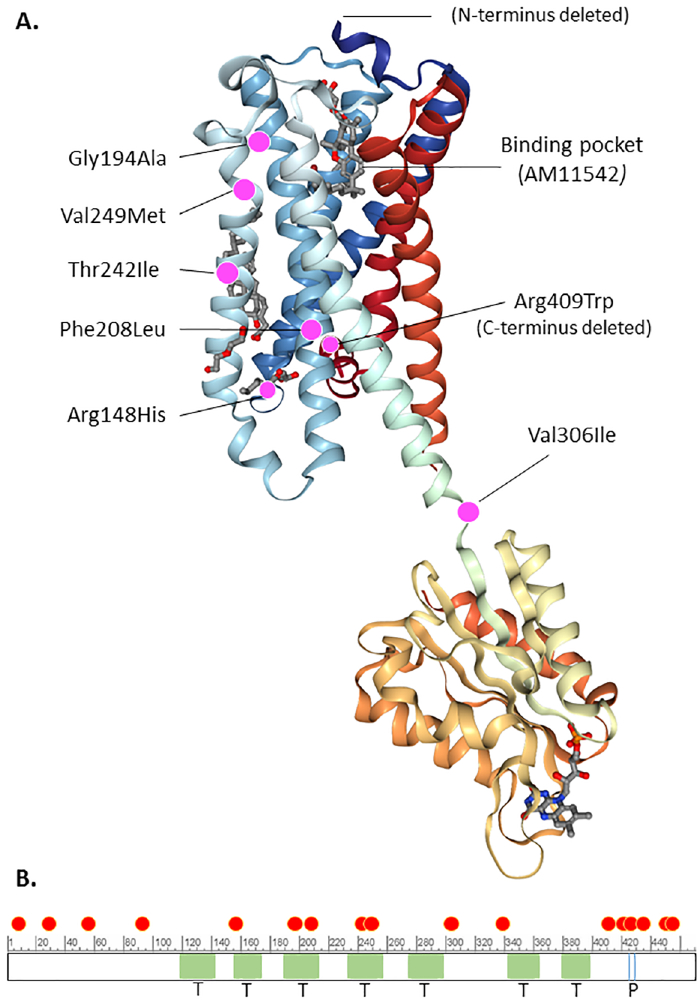
Fig 1. A. Depictionof the x-ray crystal structure of the type I cannabinoidreceptorwith bound agonist AM11542 from PDB ID 5XRA. The locationof rare coding variants that could be mapped to the structure are shown by magenta dots, with annotationsindicatingthe amino acid substitutions and the cannabinoid binding site. B. The locationof rare coding variants relative to domainsof the enzyme and regulatoryphosphorylation sites are indicated, based on NCBI Reference Sequence:NP_001153731.1. Red dot: rare variant; T (light green shading): transmembrane domain;P (blue vertical lines): phosphorylation sites.